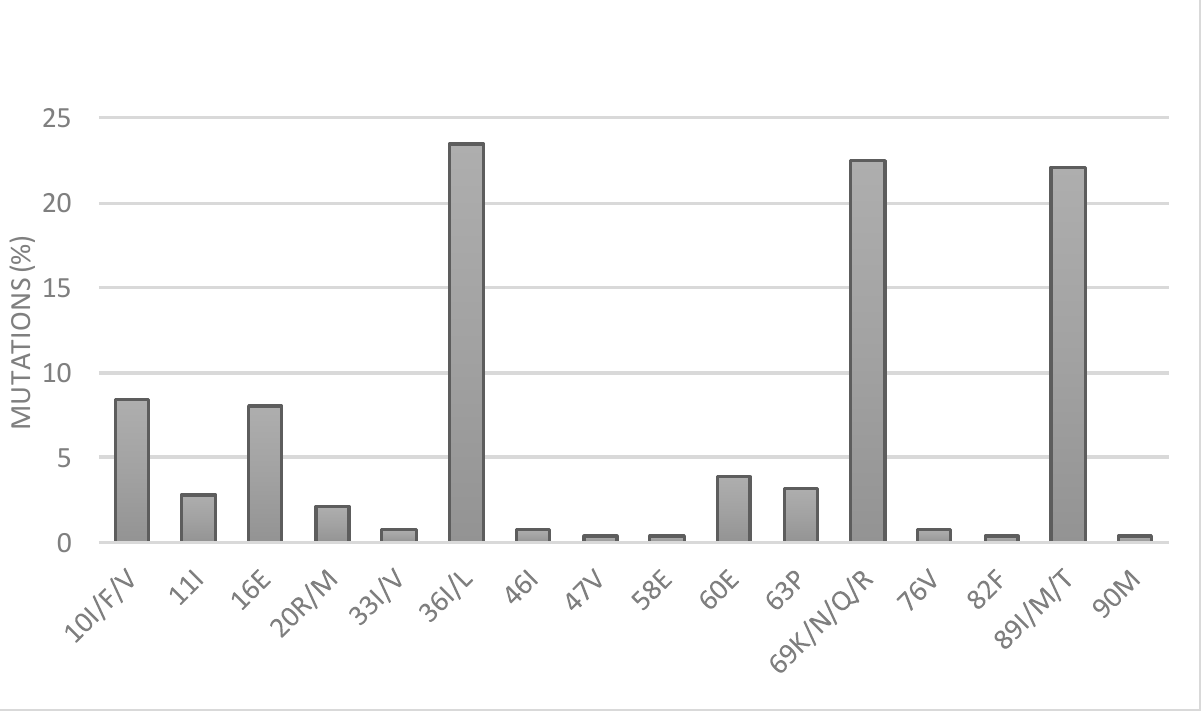
Figure 4. Observed frequency of mutations conferring resistance to protease inhibitors (PIs).